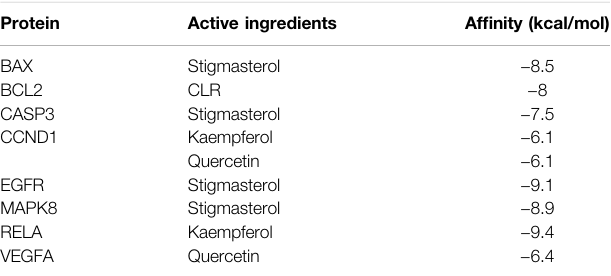
TABLE 3 | Docking scores of eight major highly expressed molecules with major active components.